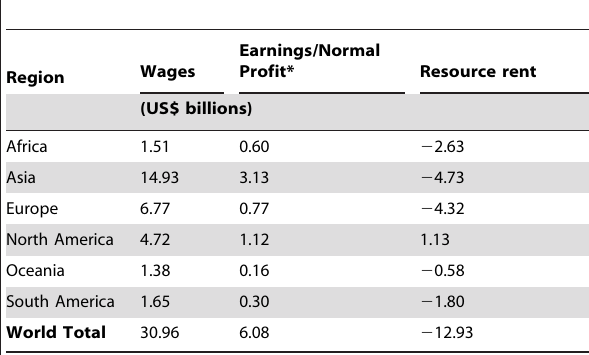
Table 2. Wages, normal profit and resource rent for current fisheries by FAO